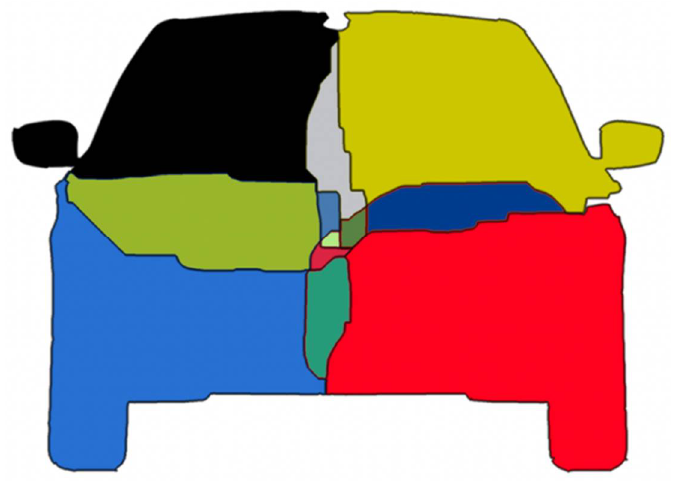
Figure 8. Labeled regions, based on connected pixels of the same quarter code.